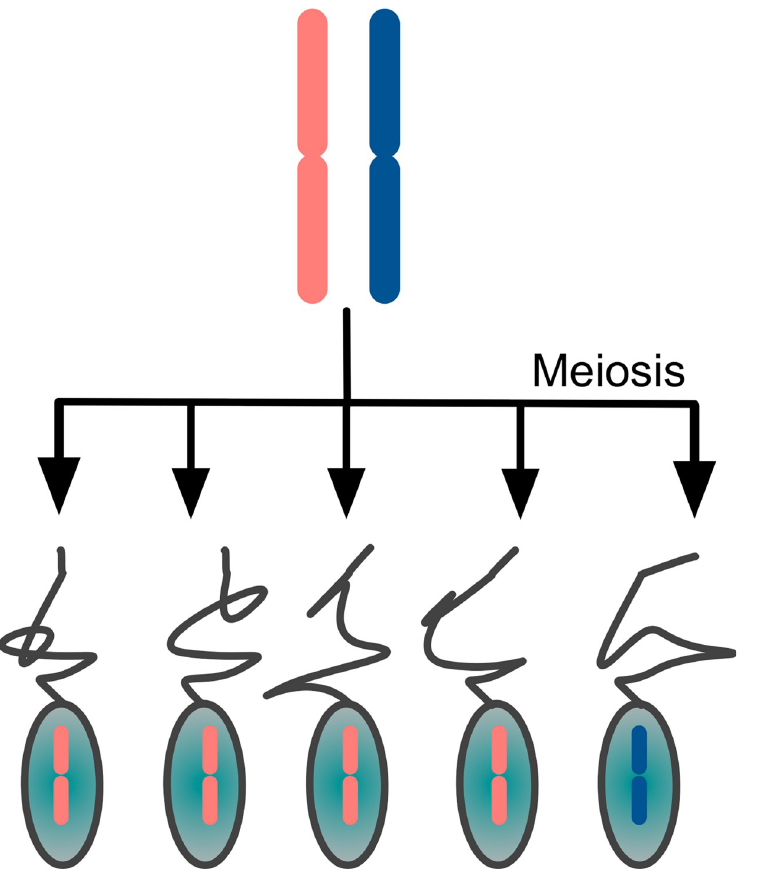
Fig 2. Segregation distorters (here shown in red) get transmitted to > 50% of the